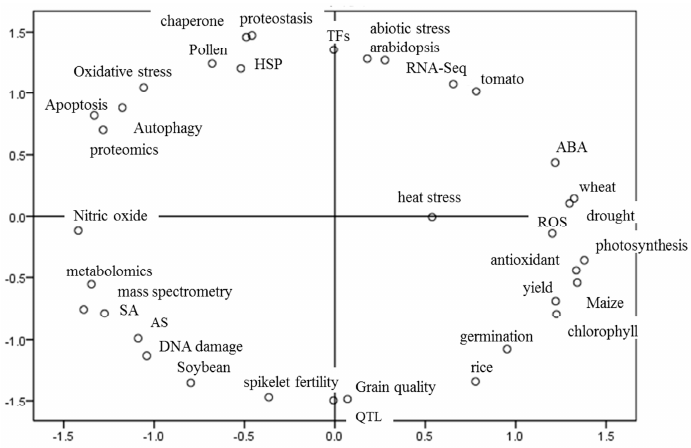
Figure 1. Keywords distribution in heat–related studies in recent years (from 2016 to 2022) by the Statistical Analysis Toolkit for Informetrics.